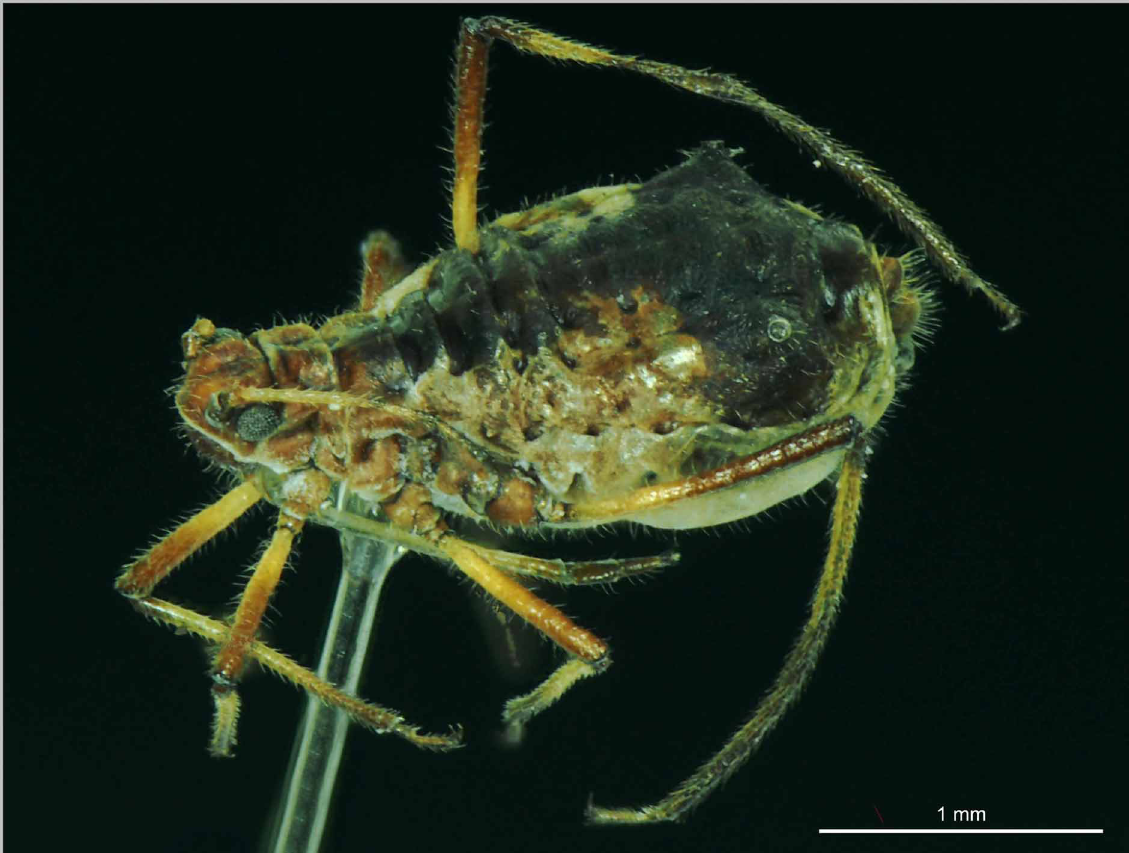
Fig. 93. Cinara (Cinara) nigritergi Mamontova-Solukha, 2002. Aptera (freeze-dried